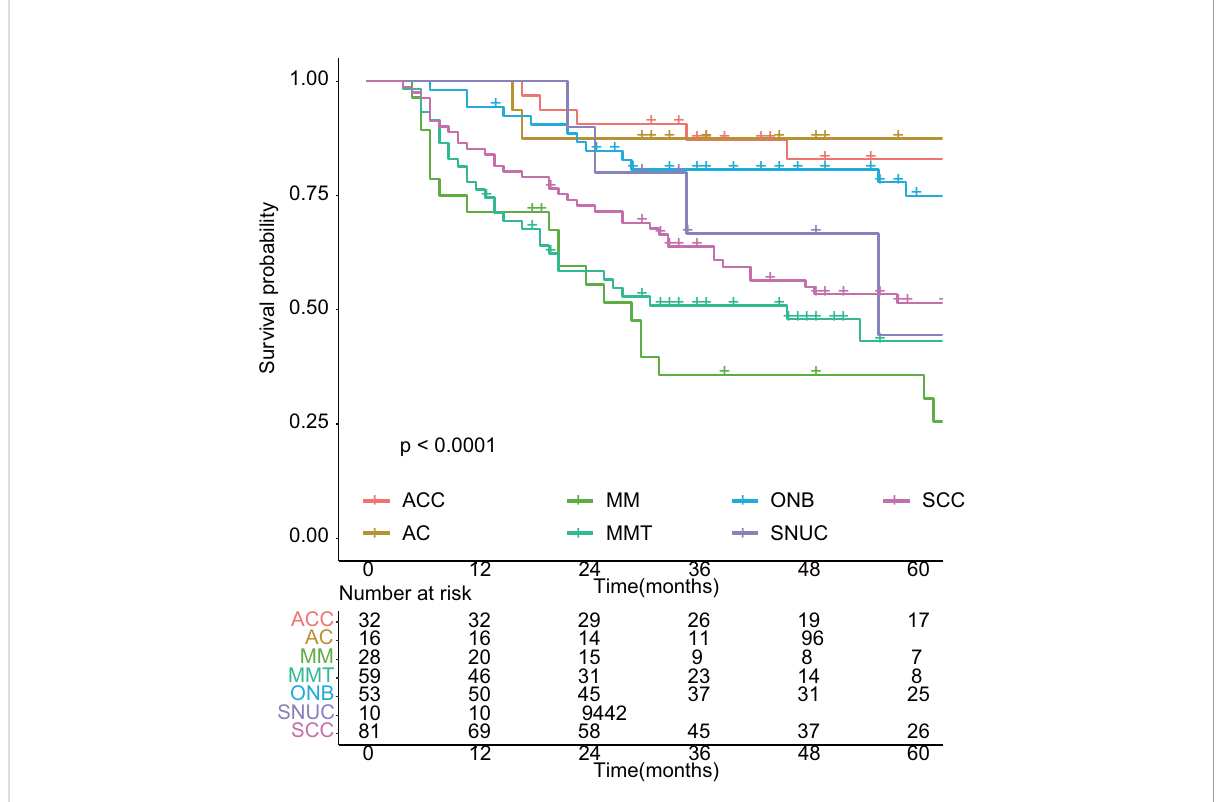
FIGURE 2 Overall survival in different histology of sinonasal malignancies. ACC: adenoid cystic carcinoma; AC: adenocarcinoma; MM: malignant melanoma; MMT: mesenchymal malignant tumor; ONB: olfactory neuroblastoma; SNUC: sinonasal undifferentiated carcinoma; SCC: squamous cell